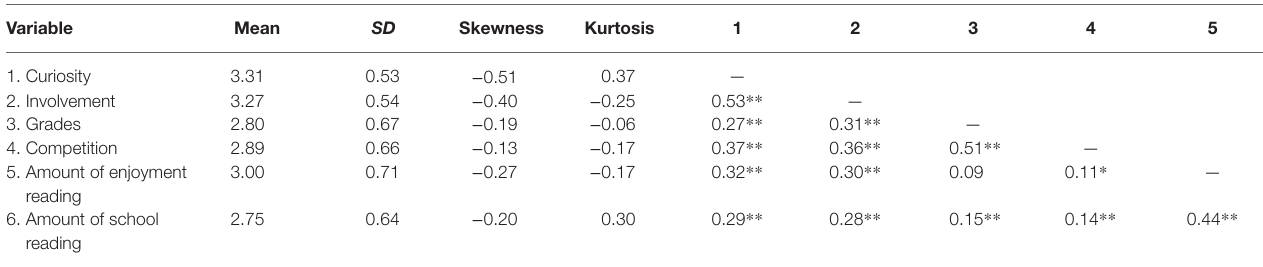
TABLE 2 | Descriptive statistics and bivariate correlations.